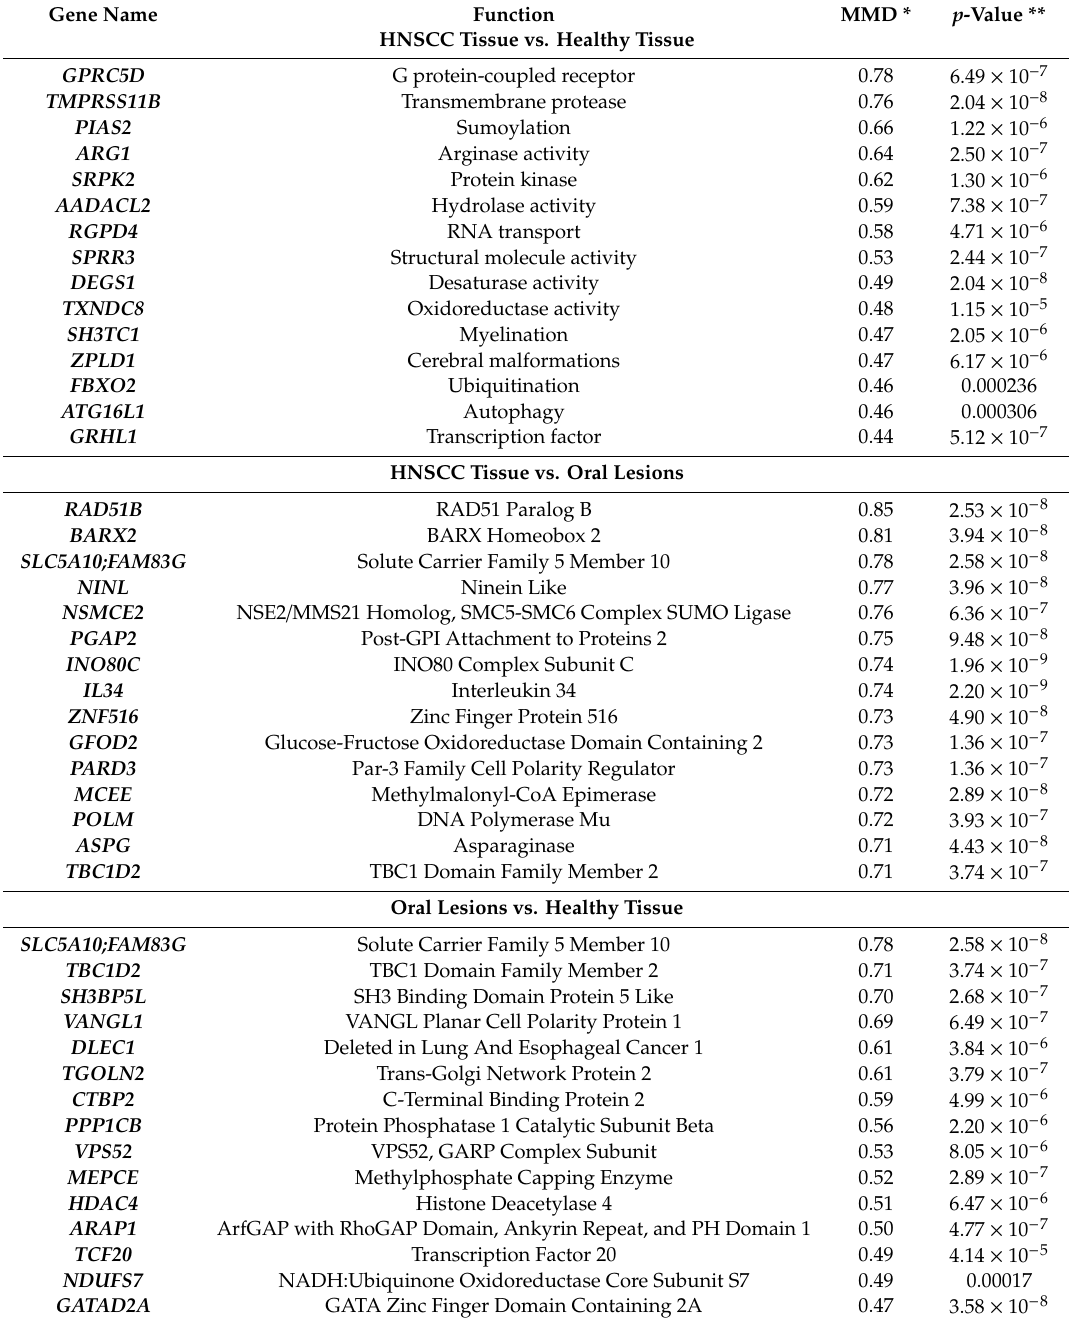
Table 1. Hypermethylated gene promoter methylation in HNSCC tissue compared to control healthy tissue and potentially premalignant oral lesions, and in potentially premalignant oral lesions compared to control healthy tissue. The list is merged of top fifteen di ff erentially methylated genes according to the extent of methylation di ff erence